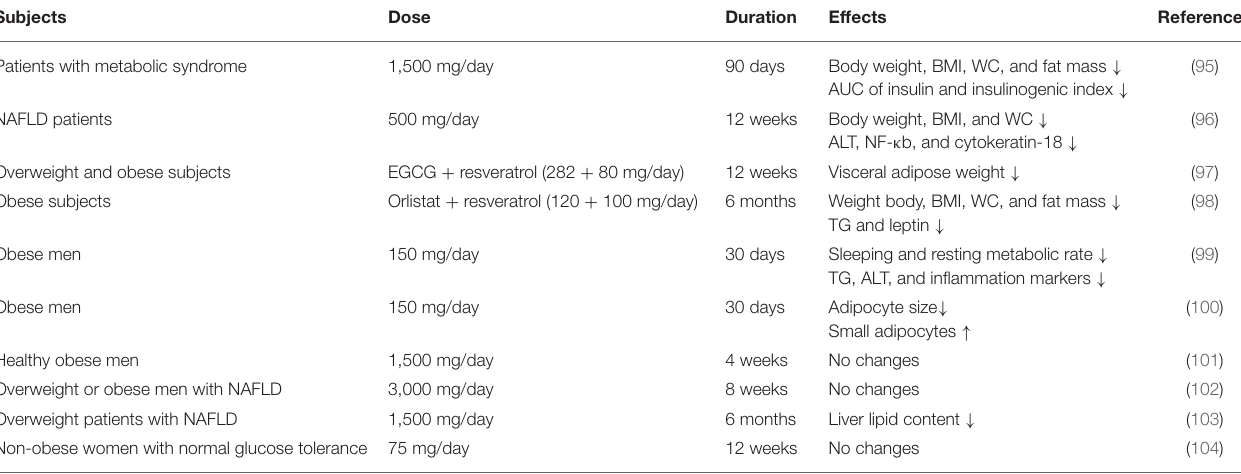
TABLE 2 | Clinical trials exploring the anti-obesity benefits of